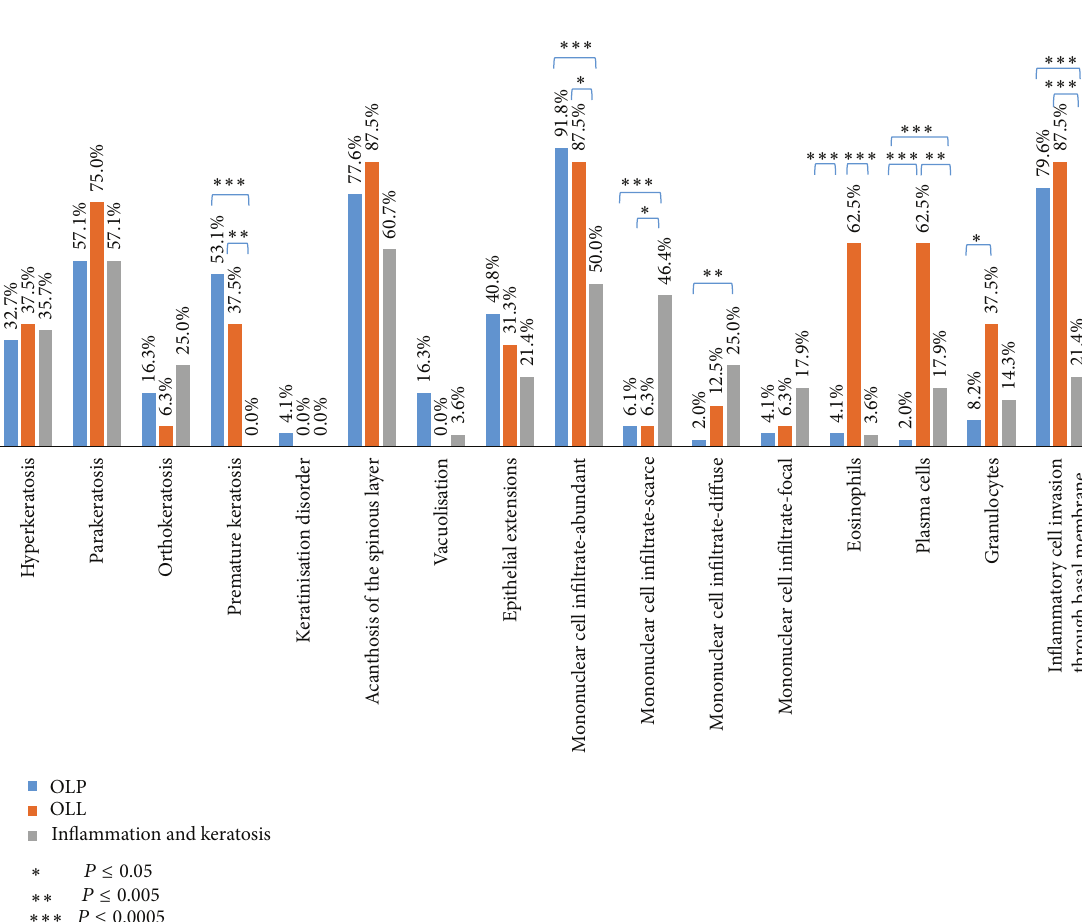
clinical diagnosis depends on a clinician interpretation [11, 14], histopathological diagnosis is strictly dependent on a pathologist interpretation as well [2, 12], but also the choice of biopsy area [18], clinical severity of the disease, activity or remission of the disease, and the clinical type of OLP (reticular lesions are considered easier for